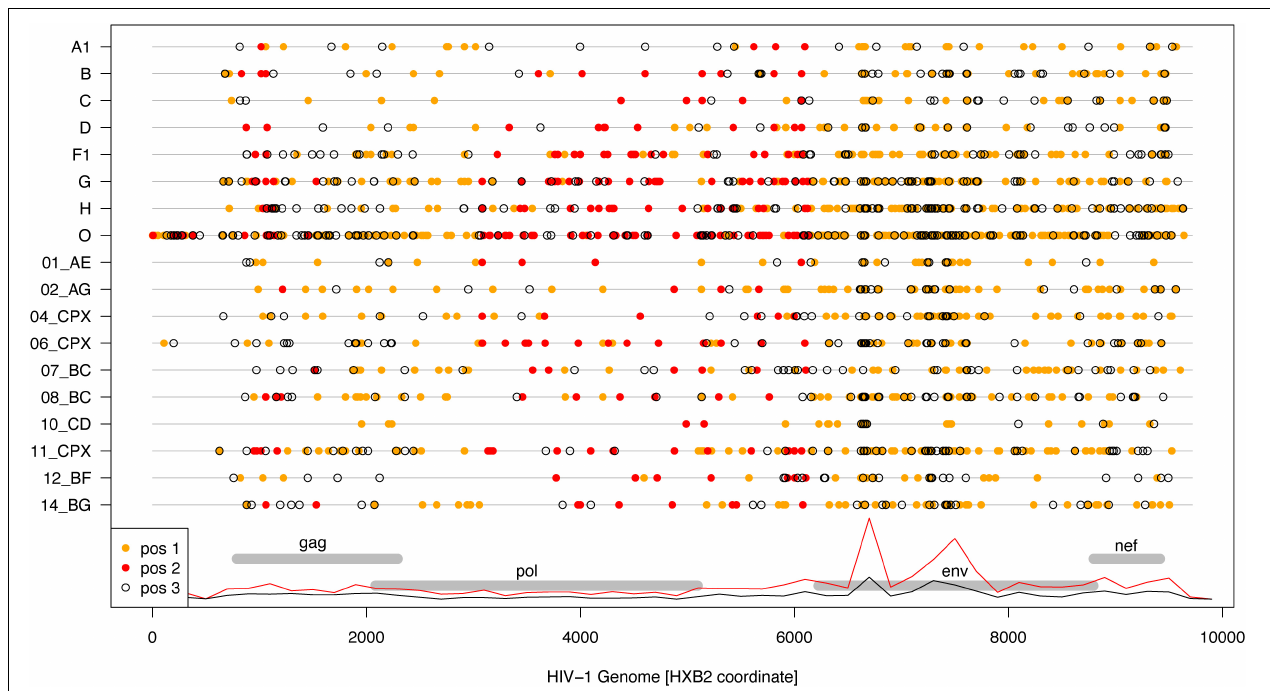
FIGURE 3 | Differences between 2002 and 2021 HIV-1 subtype/CRF consensus sequences. Dots show nucleotide state differences for 1st (orange), 2nd (red), and 3rd (open) codon positions along the respective subtype/CRF genome (gray lines). The genome locations for the structural genes are shown for reference, and overlayed with relative densities of 1st + 2nd (red) and 3rd (black) codon position differences across all